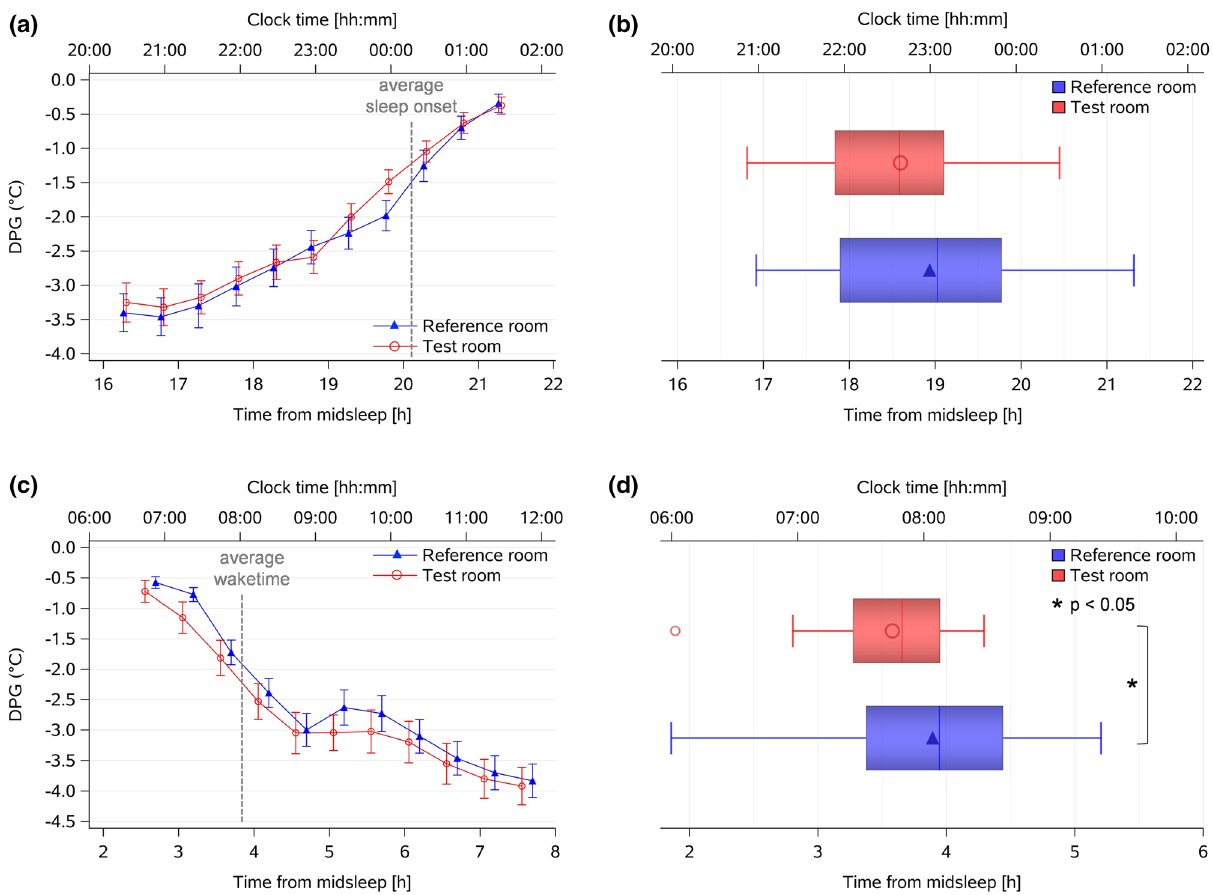
Figure 5. Evening rise and morning decline of DPG. ( a ) Averaged time-course of evening DPG, from 4 h before habitual sleep onset to 1 h after habitual sleep onset (mean ± SEM; red symbols = Test room , n = 30; blue symbols = Reference room ; n = 34); the vertical dashed lines show averaged sleep onset for both conditions; ( b ) Box plots of the DPG rise in the Test room (red symbols) and in the Reference room (blue symbols; p = 0.10). The box plots show mean (red and blue symbols inside the boxes), median (red and blue vertical lines), minimum and maximum values (red and blue horizontal bars). All times are aligned to habitual midsleep time, and corresponding clock time is shown on the upper x-axis; ( c ) Averaged time-course of the DPG decline in the morning, from 1 h before habitual waketime to 4 h after habitual waketime for both conditions separately (red circles and lines = Test room , n = 30, blue triangles and lines = Reference room , n = 34; mean ± SEM); the vertical dashed line shows averaged habitual waketime for both conditions; ( d ) Box plots of DPG decline in Test room (red symbols) and in Reference room (blue symbols, *: p =